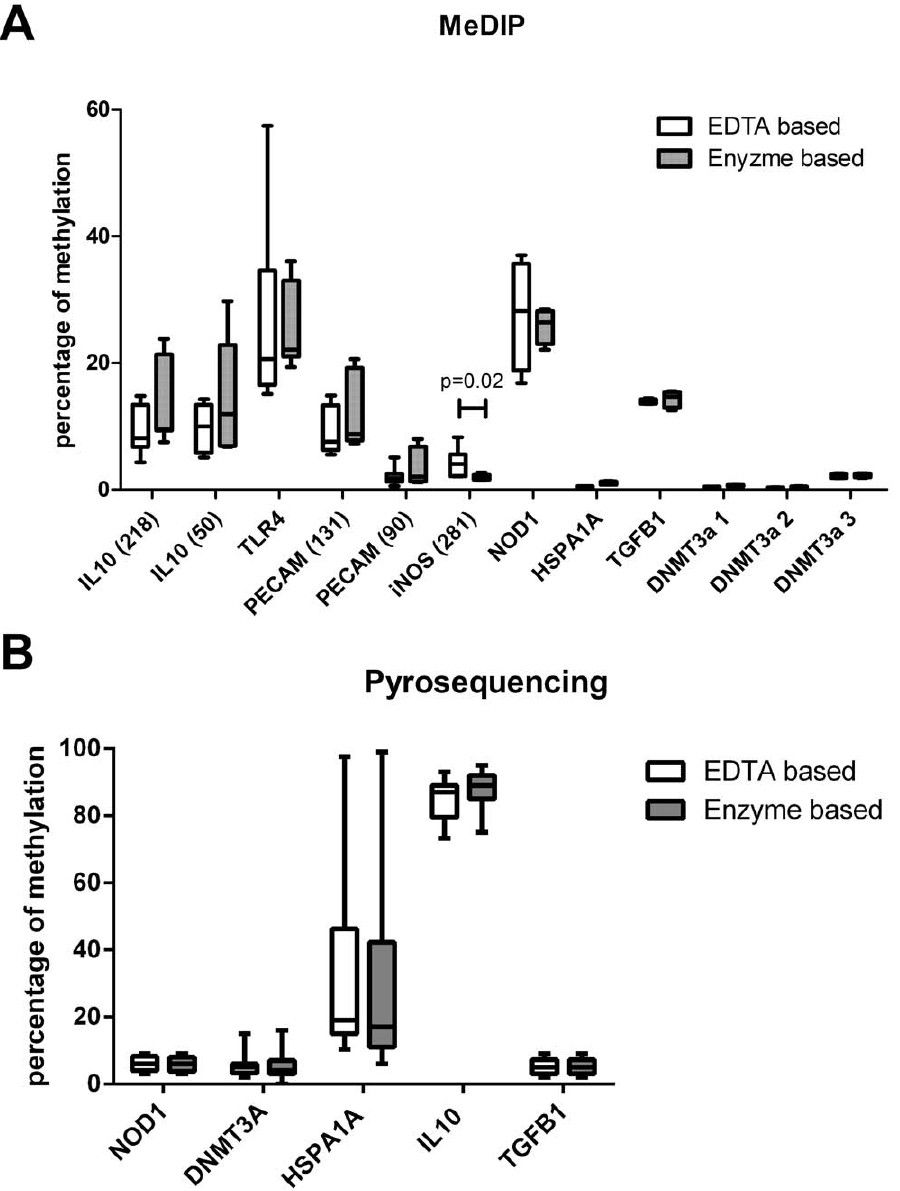
Figure 3. Analysis of cytosine methylation of promoter regions of selected genes. A) CpG methylation of promoter regions of selected genes analysed by MeDIP. B) CpG methylation of promoter regions of selected genes analysed by pyrosequencing. Data is expressed as box and whisker plots. The length of the boxes represents the interquartile range and the whiskers the 3 rd and 97 th percentile of the data. Significance testing was performed using paired Students T-test and values for p , 0.05 were considered to be statistically significant.